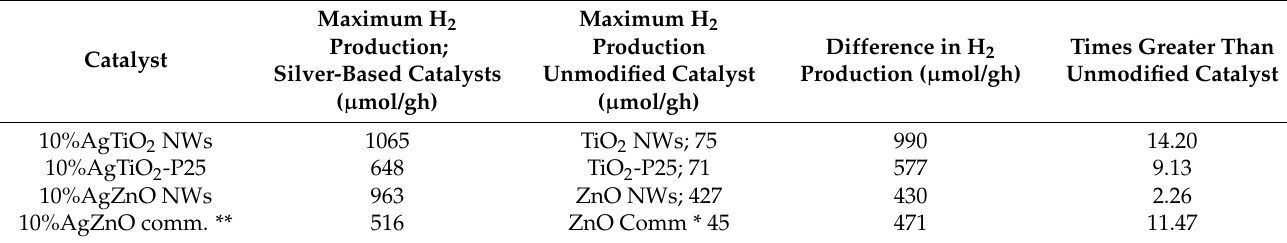
Table 3. Silver-based catalysts with the highest hydrogen production and their difference from the unmodified supports at a wavelength of 400 nm *.